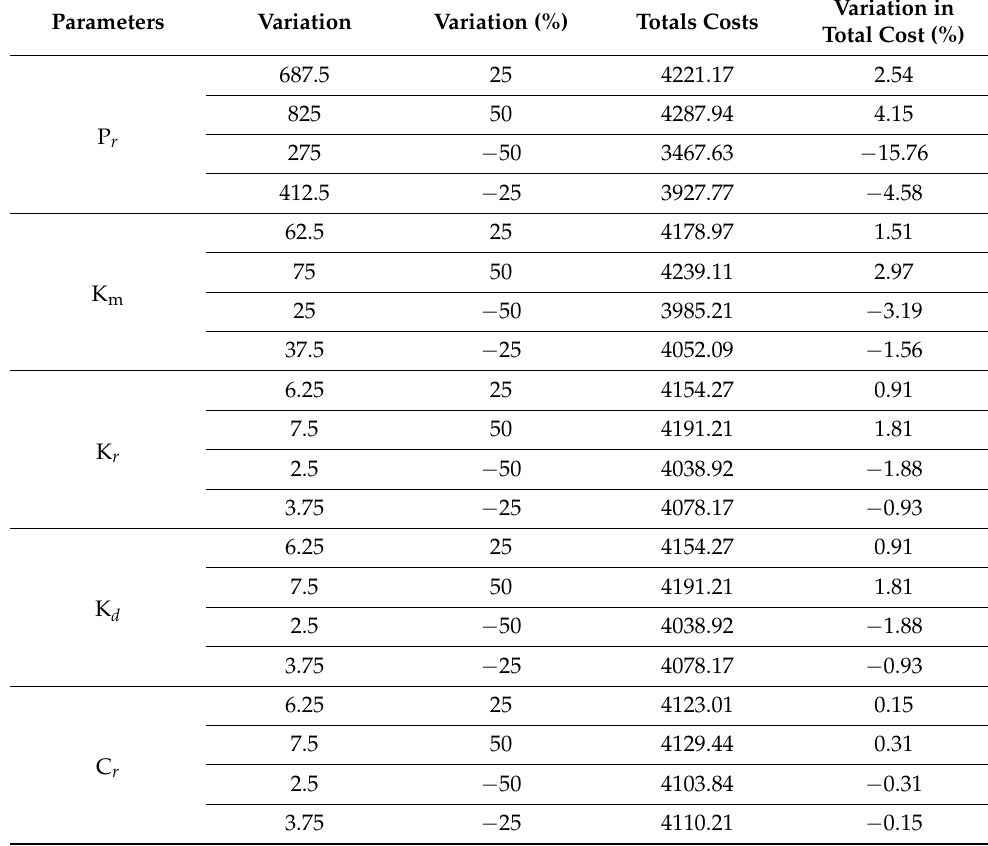
Table 6. Sensitivity analysis for basic parameters of the model presented in case